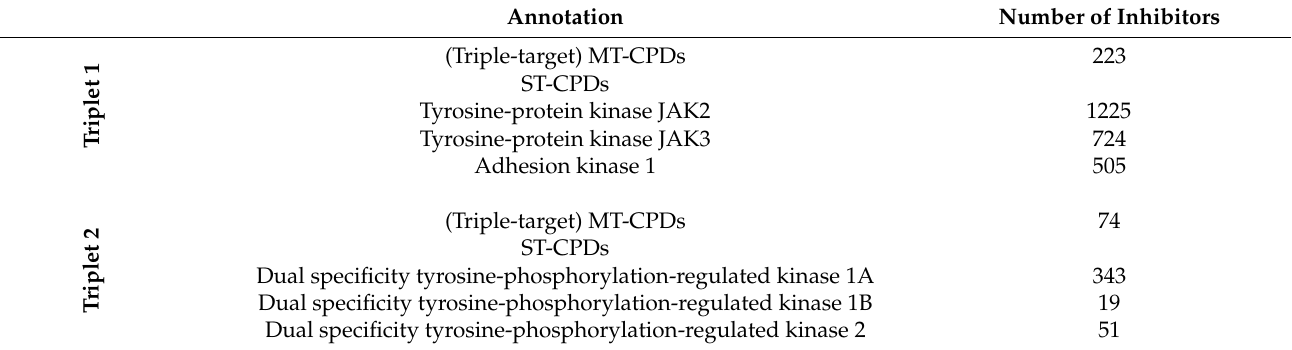
Table 1. Kinase triplets and compound